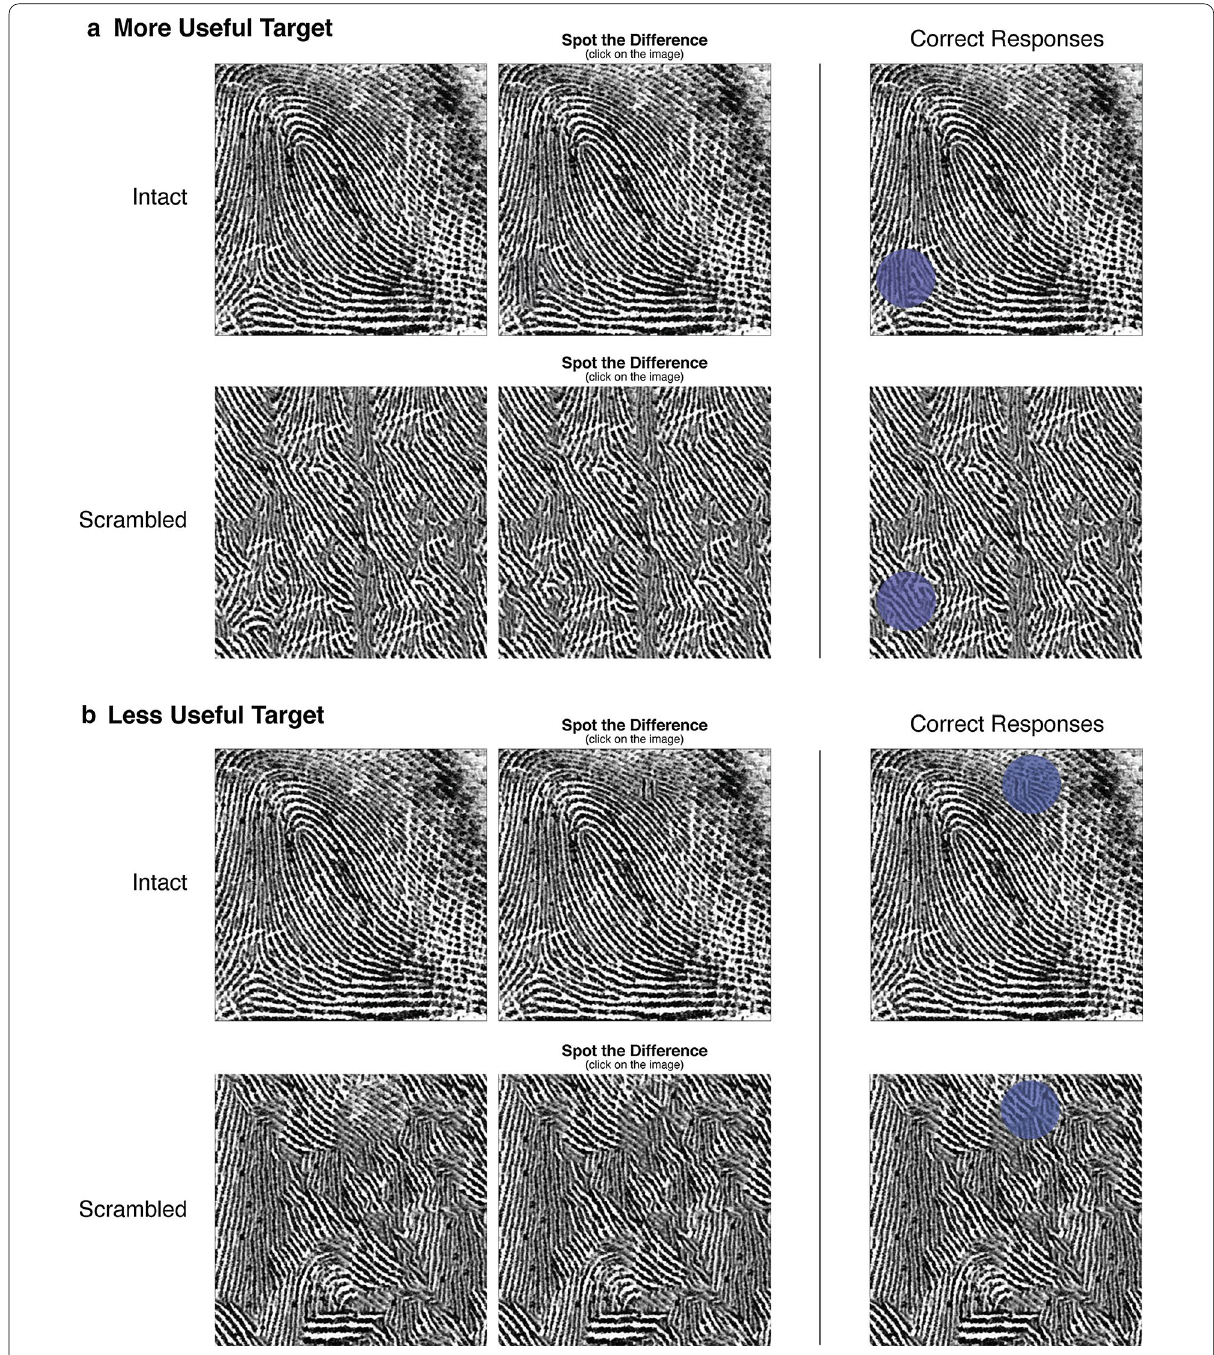
Fig. 4 A schematic diagram of the Spot-the-Difference task used in Experiment 2. We provide an example of each of the trial types on the left: either two intact fingerprints were displayed or two scrambled prints, and the target change had been made to either a ‘more useful’ feature ( a ) or a ‘less useful’ feature ( b ). When generating the scrambled fingerprints, we kept the location of the target change identical to those in the intact prints. The correct location of the change in each example is displayed on the